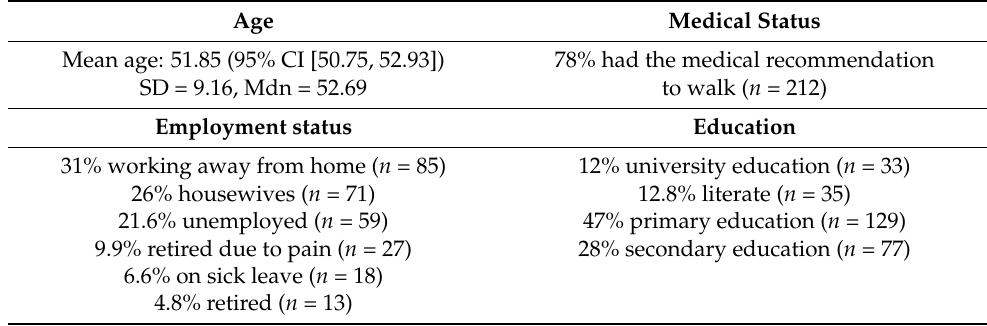
Table 2. Participant demographics data.